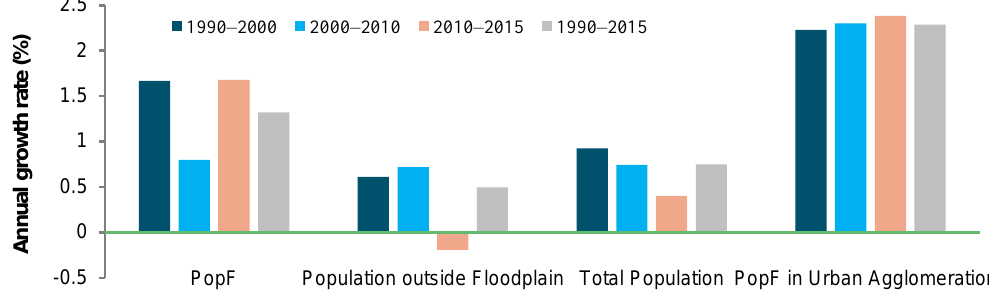
Figure 5. The annual growth rate of population in the floodplain (PopF), population outside floodplain, total population, and PopF in the three primary urban agglomerations.